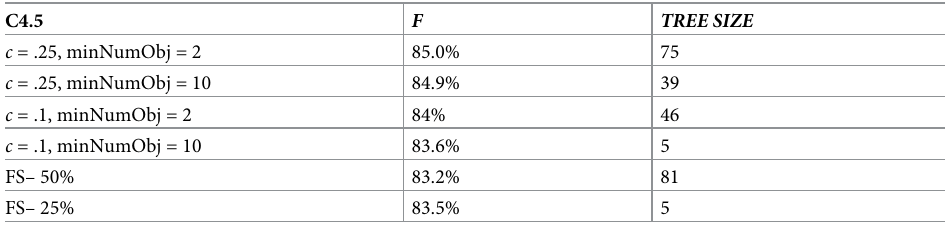
Table 5. Performance of C4.5 for the whole